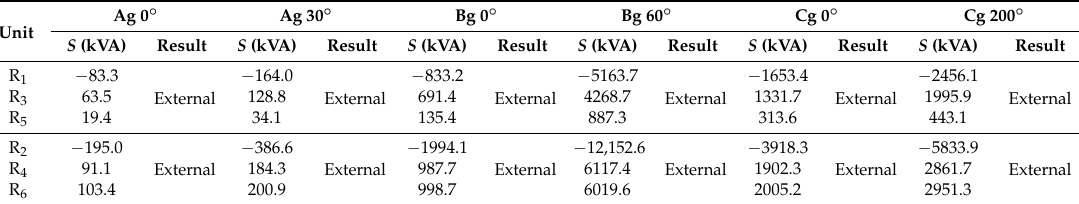
Table 4. Simulation results of the different fault inception angles for the external faults.